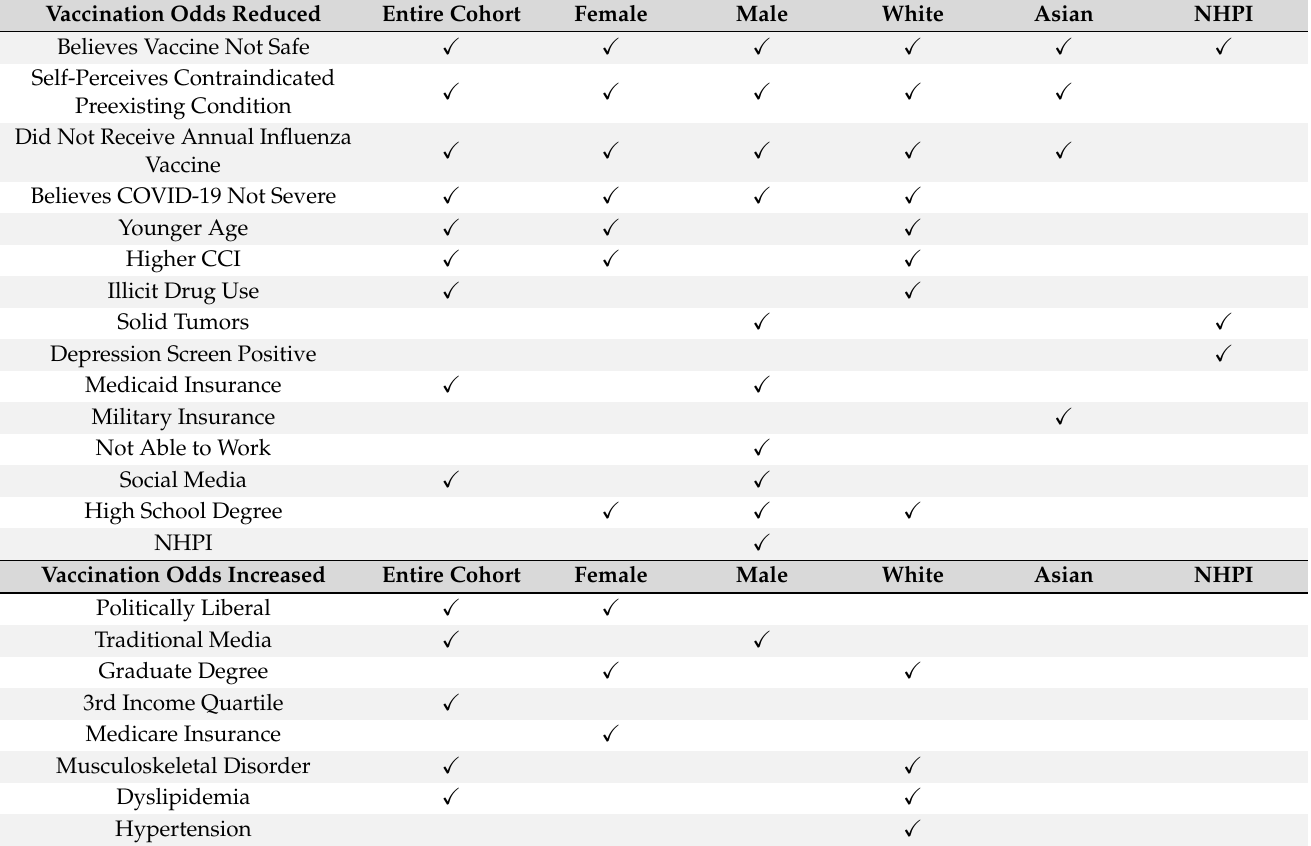
Table 10. Unadjusted odds of vaccine acceptance or hesitance amongst neurological patients. Vaccination Odds Reduced